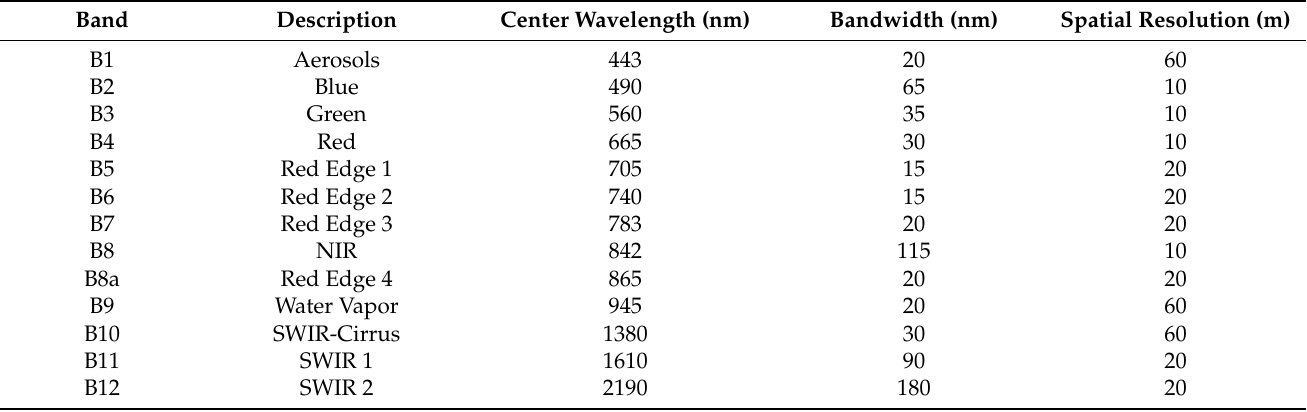
Table 1. Sentinel-2 spectral